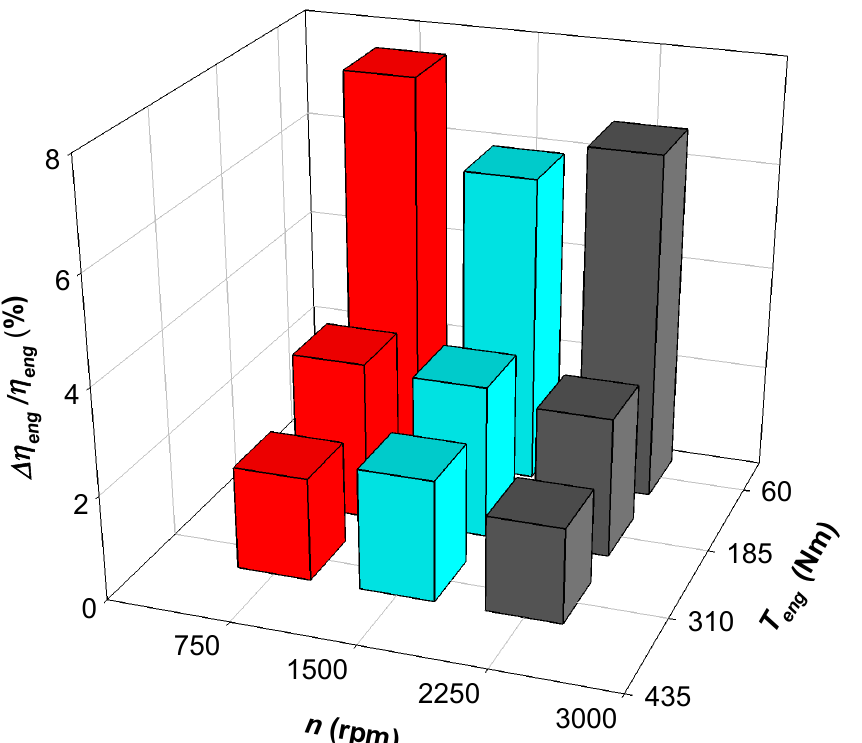
Figure 14. Engine efficiency increment at the engine operating points of the discretization grid.